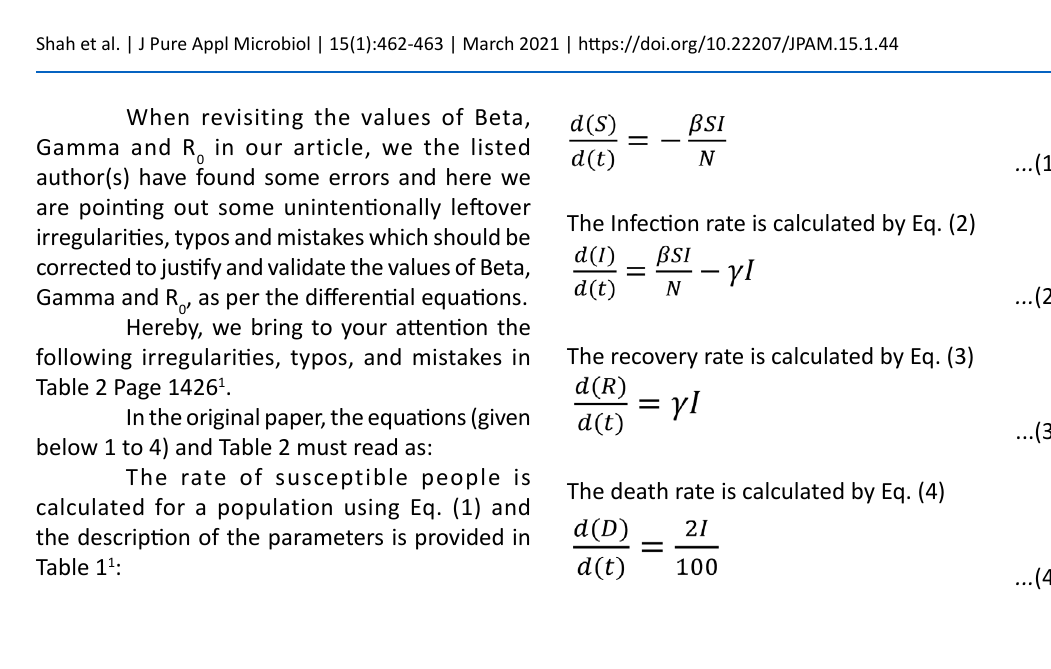
2. Prediction with different Gamma (γ) and Beta (β) value using SIRD Model Prediction with different Gamma (γ) and Beta (β) value Cases Beta